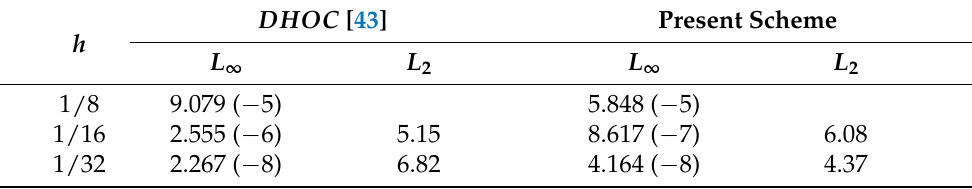
Table 9. The L ∞ error and convergence rate when τ = h 2 , α = 0.1, T = 0.5 for Problem 5.